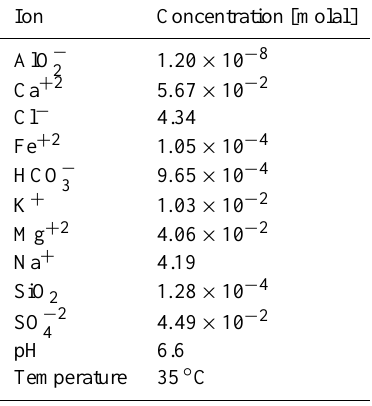
Table 1. Initial brine